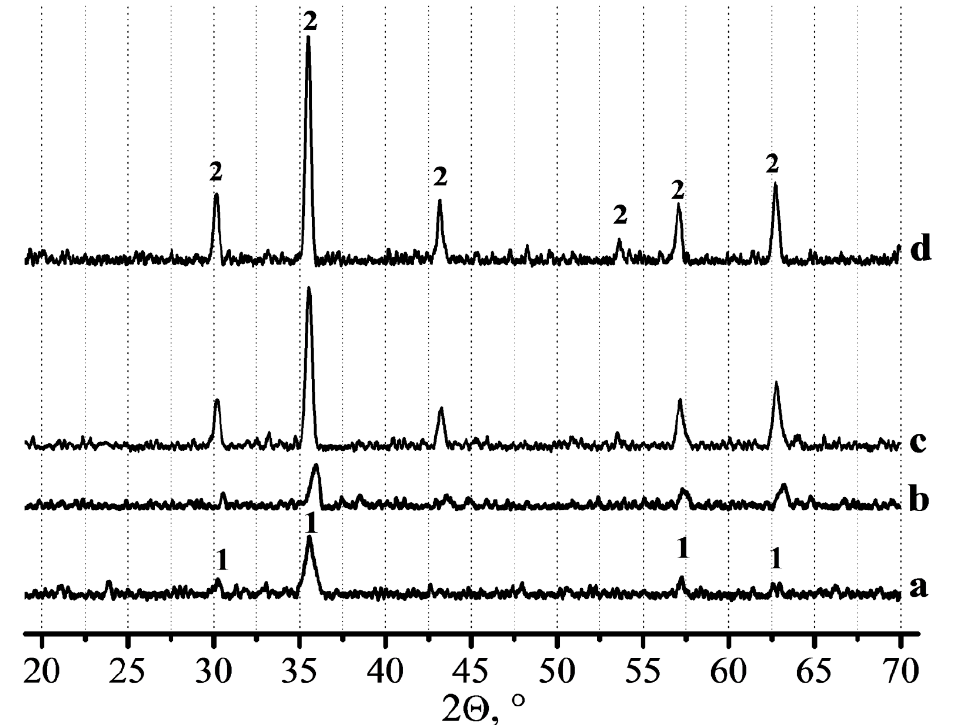
Figure 2. XRD patterns of products of mechanochemical activation of FeC 2 O 4 · 2H 2 O and CoC 2 O 4 · 2H 2 O subjected to heat treatment at the temperatures, ° С : ( а )—300, ( b )—350, ( с )—450, ( d )—500; 1— γ -Fe 2 O 3 ; 2—CoFe 2 O 4.